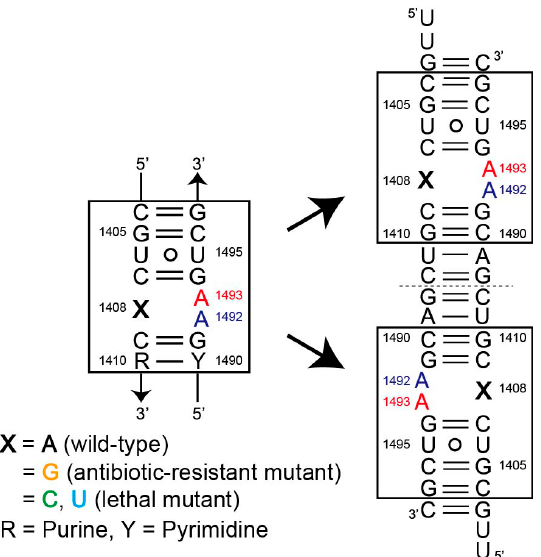
Figure 1. Secondary structures of the RNA duplexes used in our present and previous crystallographic studies. The two bacterial A-site molecular switches are boxed. A uracil residue at position 11 is replaced by a 5-bromouracil in bromine-derivatives. Two adenine residues A1492 and A1493 that recognize the codon-anticodon helix are colored in blue and red, respectively.